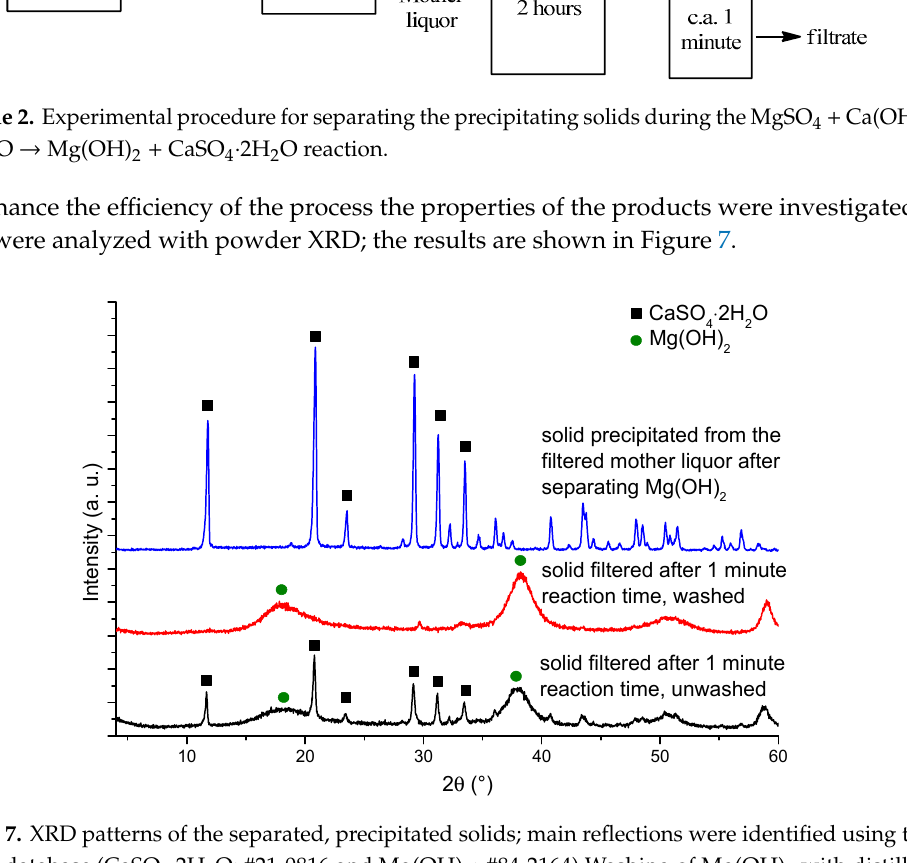
Table 2. Summary of gypsum content in the washed precipitated solids taken at given times in the